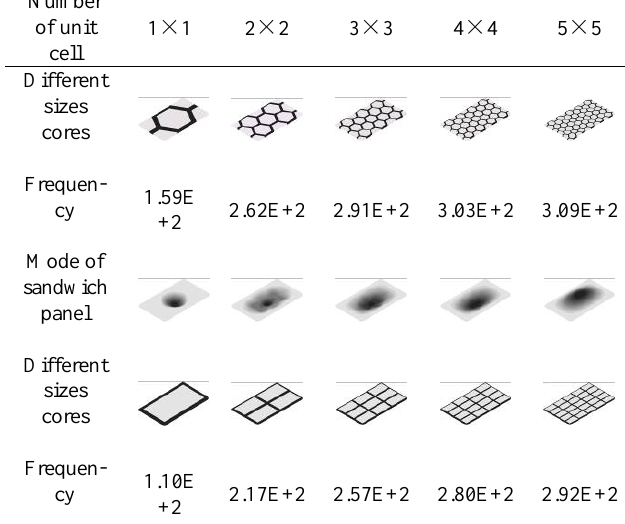
. Frequency variation of the first order vibration Fig. with 16 different size (a) hexagonal and (b) rectangular cores